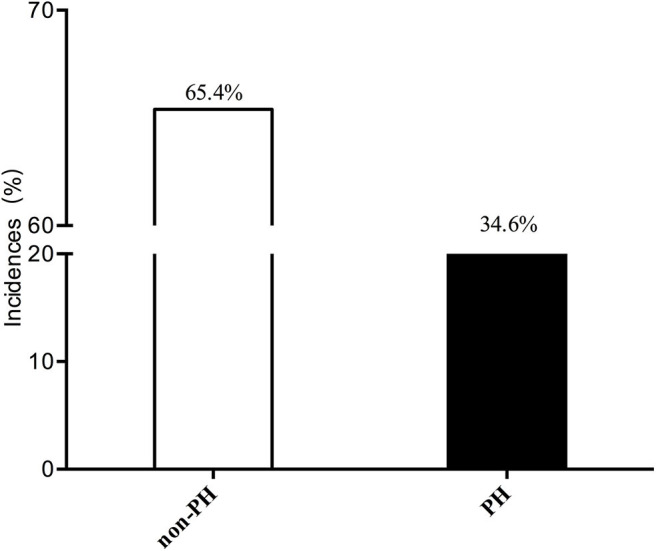
Incidence of PH in ESRD patients.